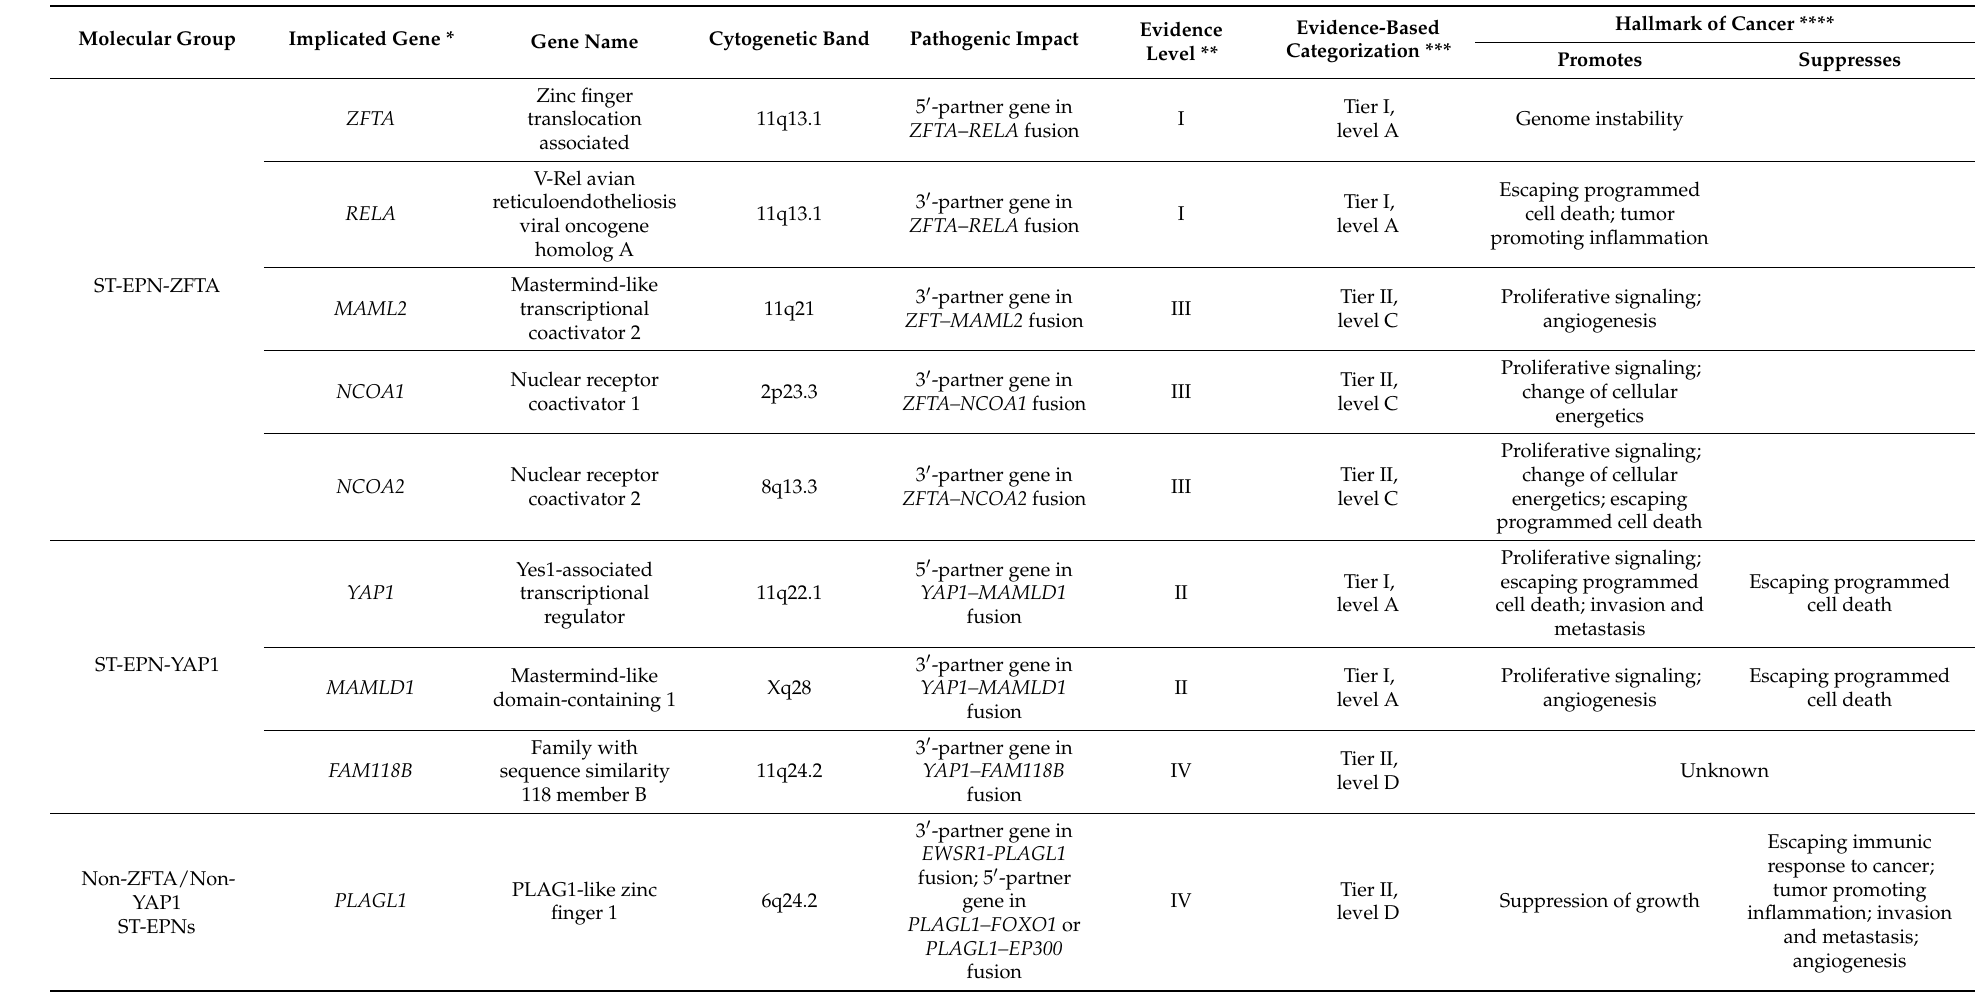
Table 2. Subgroup-specific diagnostic marker and candidate genes involved in recurrent chromosomal abnormalities in pediatric